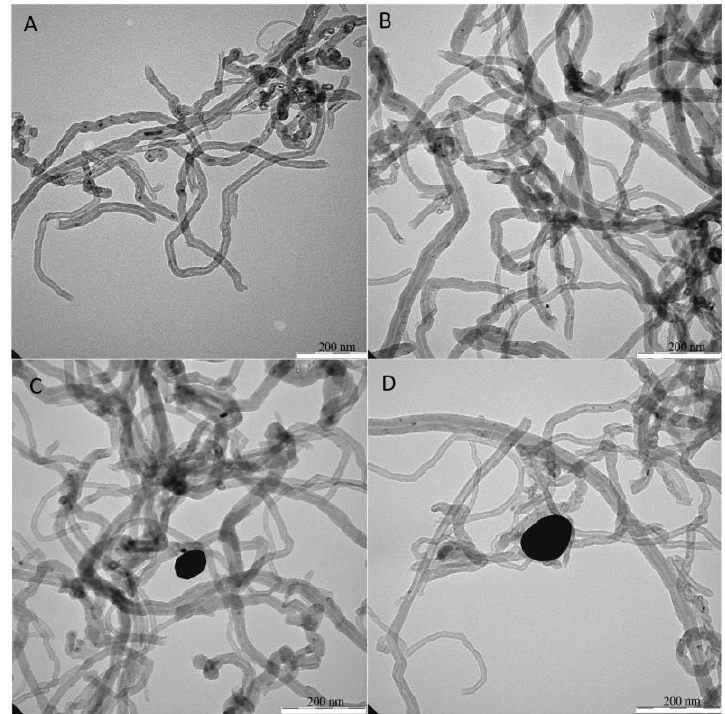
Figure 1. TEM images of IV B and VIII B. Panels A and C represent the oxMWCNTs and Au–MWCNTs after the loading procedure of IBX. Panels B and D represent IV B and VIII B recovered after the oxidation of alcohol 1. In panels C and D, the black spot corresponds to the Au particle. ( A ) IBX-MWCNTs IV B; ( B ) IBX-MWCNTs IV B after the oxidation of alcohol 1 ; ( C ) IBX–Au–MWCNTs VIII B ; ( D ) IBX–Au–MWCNTs VIII B after the oxidation of alcohol 1.